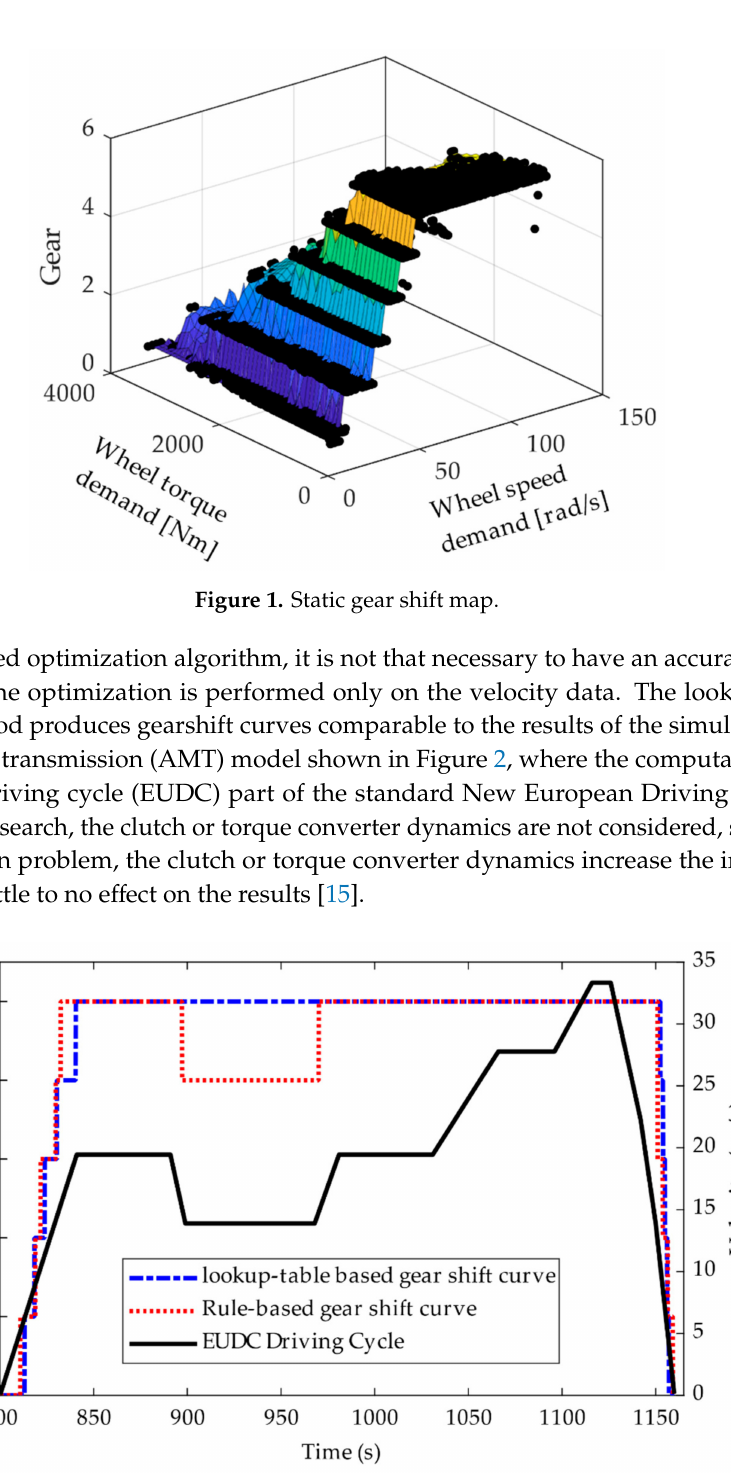
Figure 2. Comparison of the rule-based and the lookup table-based gear shift curve for the extra-urban driving cycle (EUDC) driving